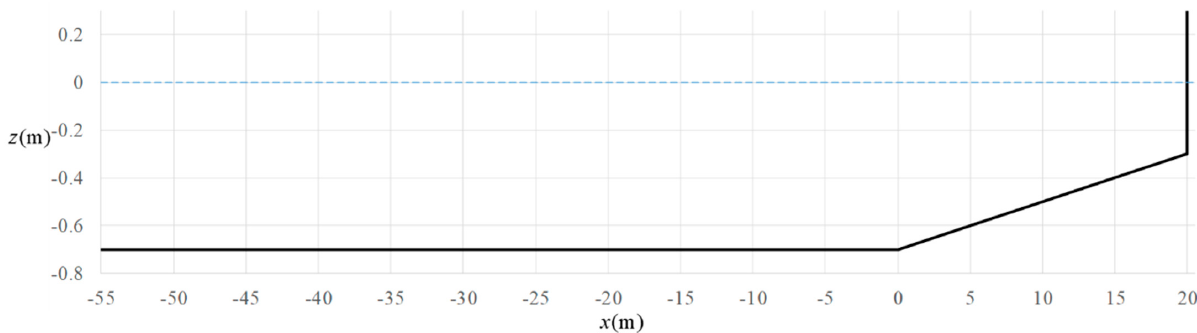
Figure 2. B athymetry for test case of solitary wave reflection after running up a slope. Figure 2. Bathymetry for test case of solitary wave reflection after running up a